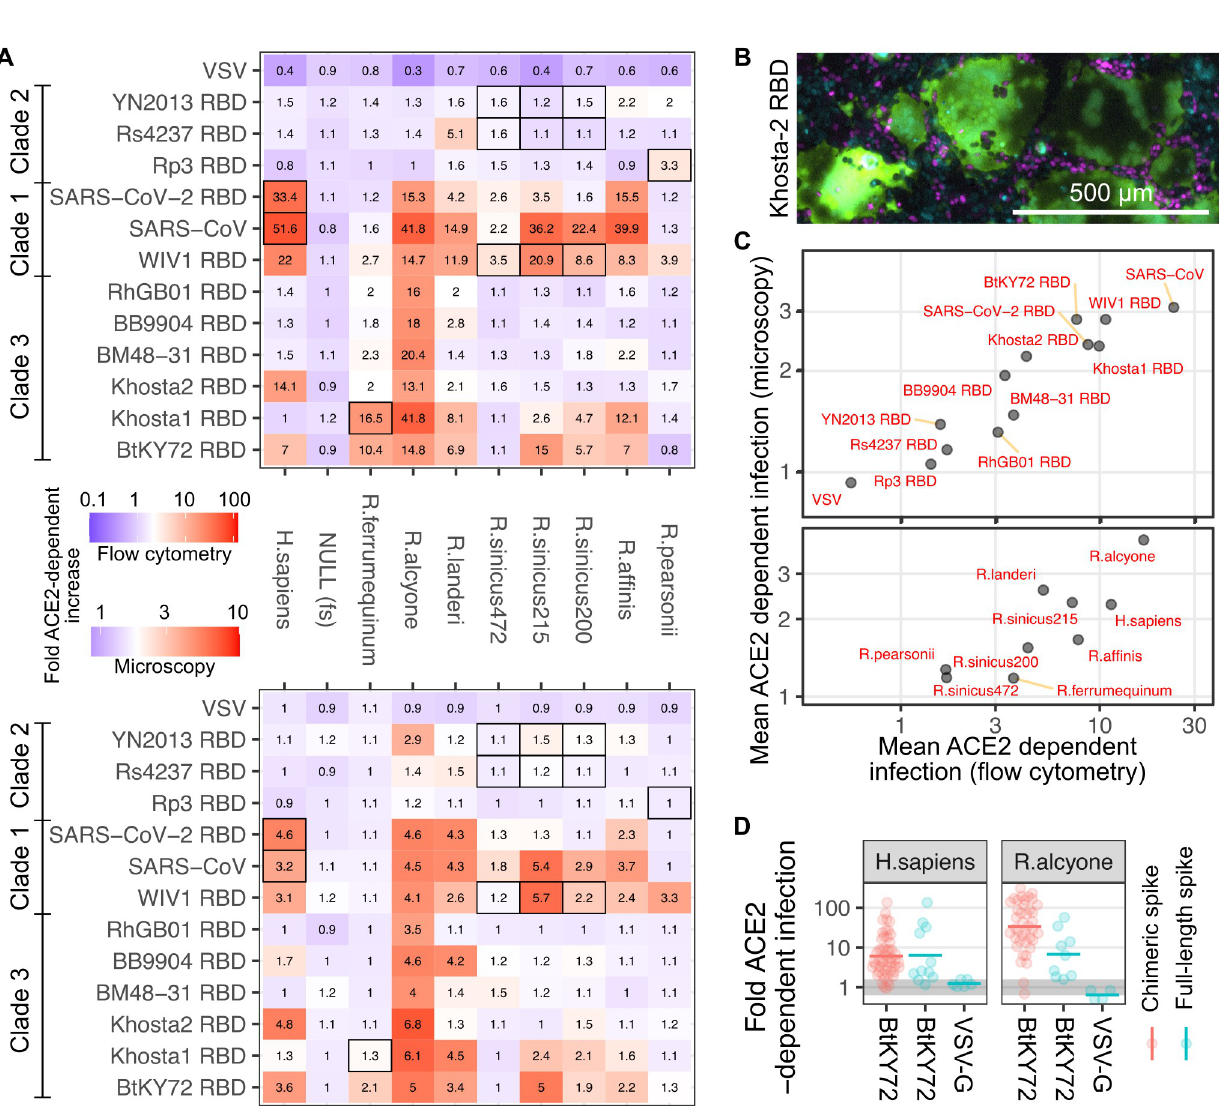
Fig 5. Infection of cells expressing rhinolophid ACE2 ectodomains with RBD chimeric spike protein pseudoviruses. (A) Heatmaps showing the amount of ACE2-dependent infection observed between various combinations of ACE2 proteins and RBD chimeric SARS-CoV spike proteins, or VSV-G, as measured with flow cytometry (top) or microscopy (bottom). Inset numbers denote the geometric means of the replicate experiments. Black box outlines denote the host species recorded at time of virus sampling and sequencing. To avoid disruption of syncytia, the amount of ACE2-dependent infection was quantified by looking for mCherry or iRFP670 fluorescence overlap with GFP fluorescence in microscopic images of adherent cells. (B) Representative image of large GFP-positive syncytia observed in R . alcyone ACE2 cells infected with Khosta-2 RBD pseudovirus, and a subset of other samples. Magenta and cyan shapes are mCherry and iRFP670-positive nuclei, respectively. (C) Scatter plots showing the mean ACE2-dependent infectivities for each RBD observed across all cell lines expressing various ACE2 orthologs (top), or the mean ACE2-dependent infectivities for each ACE2 ortholog across all RBDs tested (bottom). (D) Comparisons of the ACE2 dependencies of pseudotyped viruses harboring RBD-chimeric or full-length spikes for BtKY72. VSV-G is shown as a comparison, with the gray line denoting an ACE2 dependence ratio of 1.The horizontal dash symbol is the geometric mean of the replicate infection assay results, shown as semitransparent points. All constructs encode human TMPRSS2 C-terminally linked to ACE2 with a 2A translational stop-start sequence. The underlying data can be found in S2 Data, and the source code can be found at https://github.com/ MatreyekLab/ACE2_dependence. ACE2, angiotensin converting enzyme-2; GFP, green fluorescent protein; RBD, receptor binding domain; SARS-CoV, Severe Acute Respiratory Syndrome-related Coronavirus; SARS-CoV-2, Severe Acute Respiratory Syndrome-related Coronavirus 2; VSV, vesicular stomatitis virus; VSV-G, vesicular stomatitis virus glycoprotein. ( Figs 5C and S7 and S8 ), providing additional confidence in the results. Regardless of the readout, the controls performed as expected, wherein VSV-G-coated pseudoviruses did not